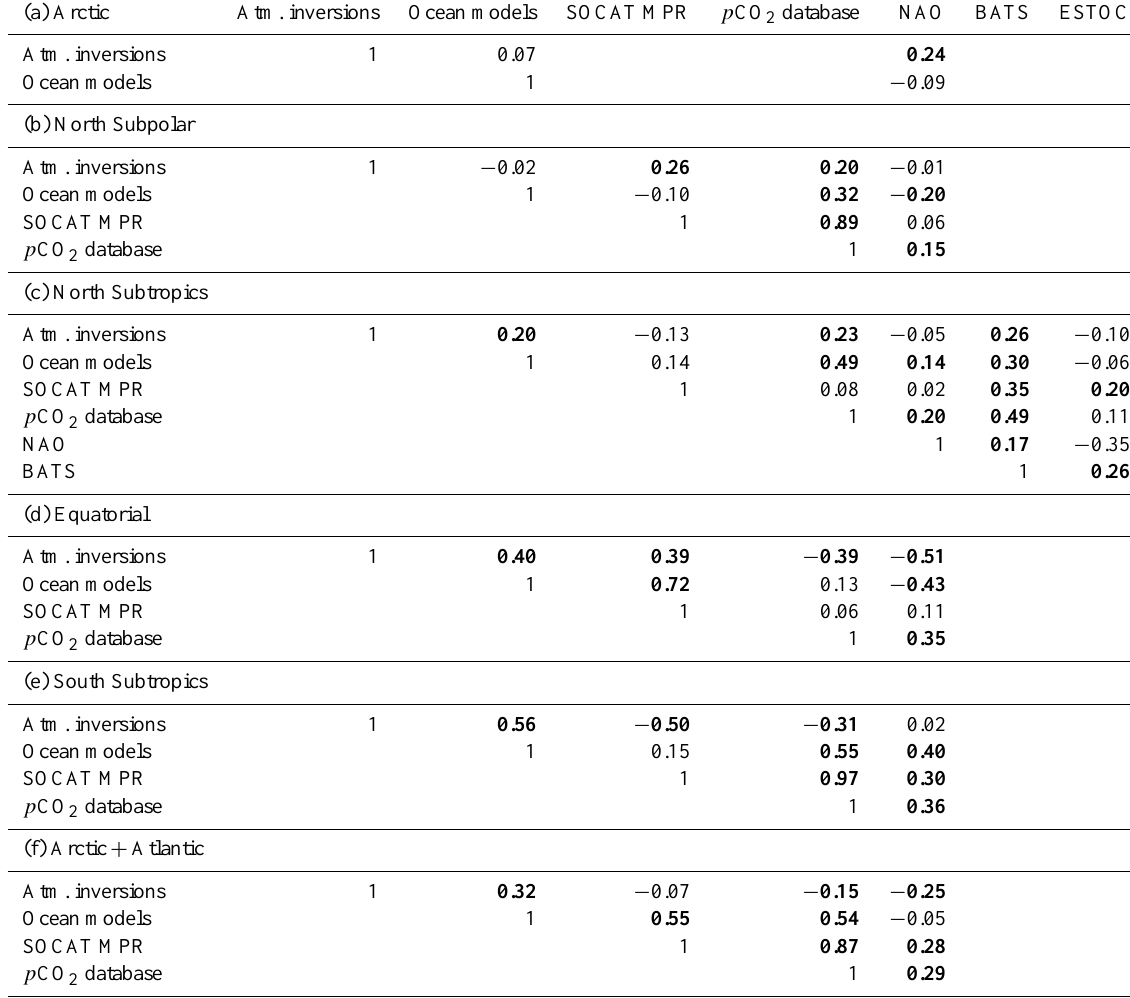
Table 7. Correlations of low-frequency interannual variability for each region between methodologies. Correlation to the monthly NAO index, smoothed with a 12-month filter, are included for all regions. For the North Subtropics, we include correlations to BATS and ESTOC. All correlations are at zero time lag. Significant correlations ( p < 0.05) are in bold. Time periods for each methodology are as noted